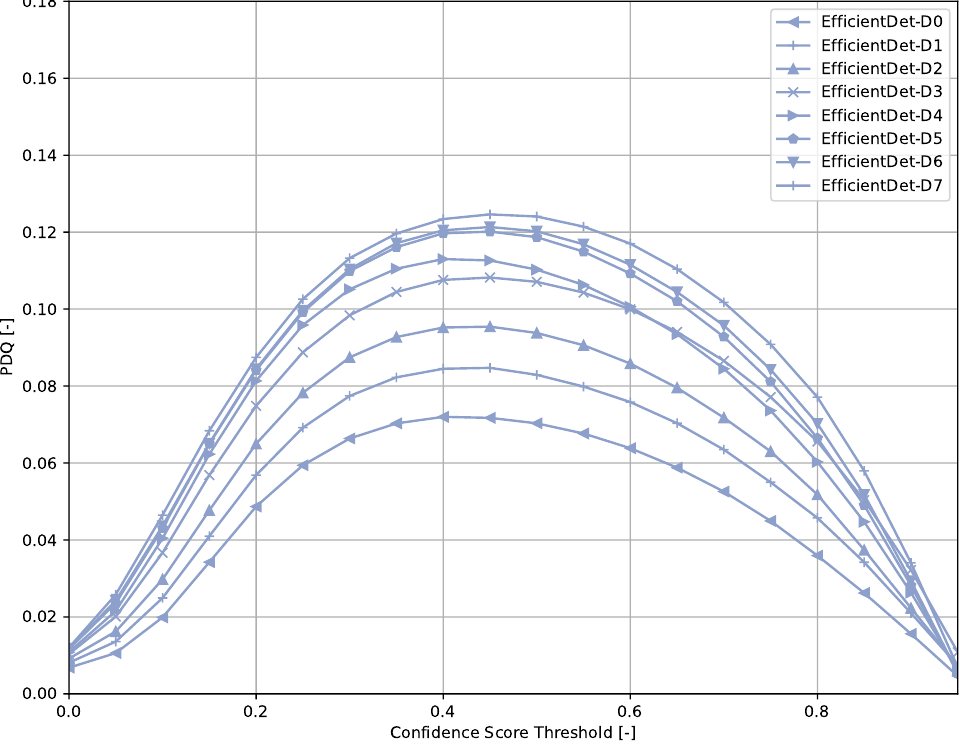
Figure 8. PDQ results of EfficientDet on the COCO dataset.